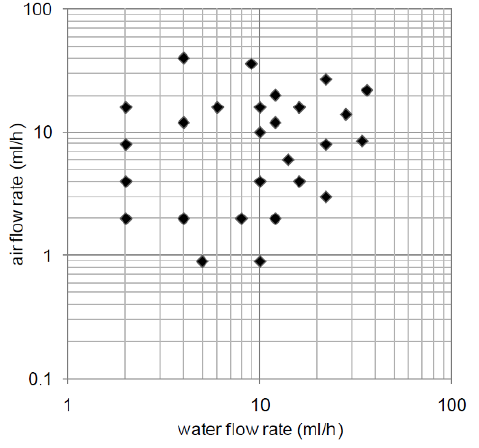
Figure 11. Flow rate